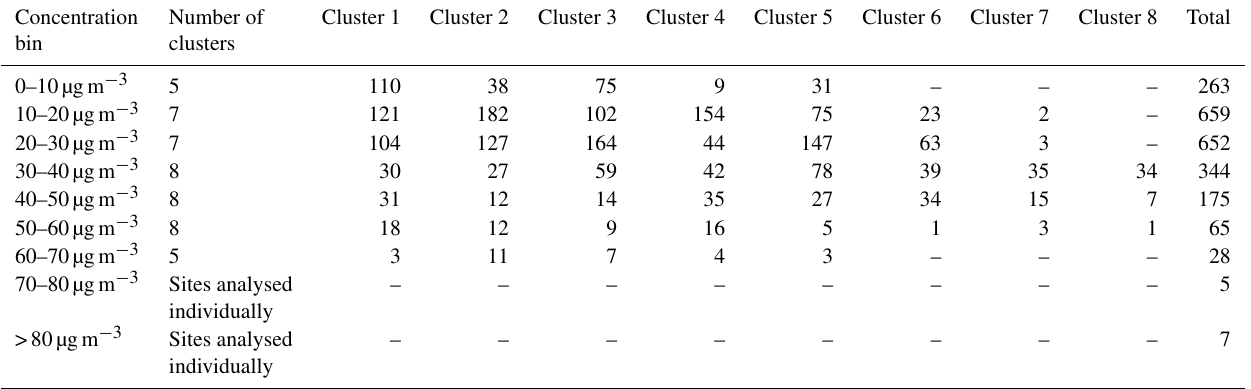
Table 2. The number of sites in each 2010–2014 average annual NO 2 (NO 2AA ) concentration bin with sufficient data capture to calculate monthly, hour of day, and hourly concentration contributions to 2010–2014 NO 2AA , split by the clusters demarcating distinct variation in monthly, hour of day, and hourly NO 2 concentration bin contributions to NO 2AA